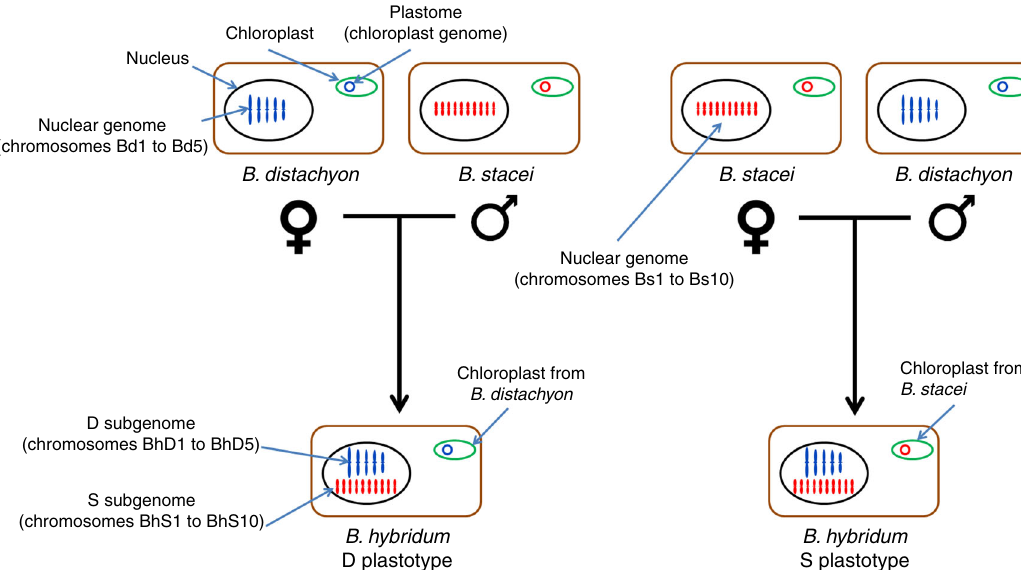
Fig. 1 Brachypodium hybridum subgenome and plastotype naming convention. Brachypodium hybridum has formed more than once from reciprocal crosses. We can use chloroplast genome (plastome) sequence to determine the maternal progenitor species of any B. hybridum line. To facilitate writing about the origin of individual lines, we designate lines that had B. distachyon as a maternal progenitor species as D plastotype, and lines that had B. stacei as a maternal progenitor species as S plastotype. The chromosomes of B. distachyon are named Bd1 to Bd5, and the chromosomes of B. stacei are named Bs1 to Bs10. To allow us to easily link B. hybridum chromosomes to their diploid orthologs, we named B. hybridum chromosomes BhD1 to BhD5 for chromosomes derived from B. distachyon and BhS1 to BhS10 for chromosomes derived from B. stacei . The diagram shows stylized plant cells with color coding, indicating the origin of the plastome and nuclear genomes ( B. distachyon -type, blue; B. stacei -type, red). For clarity, the haploid number of chromosomes is